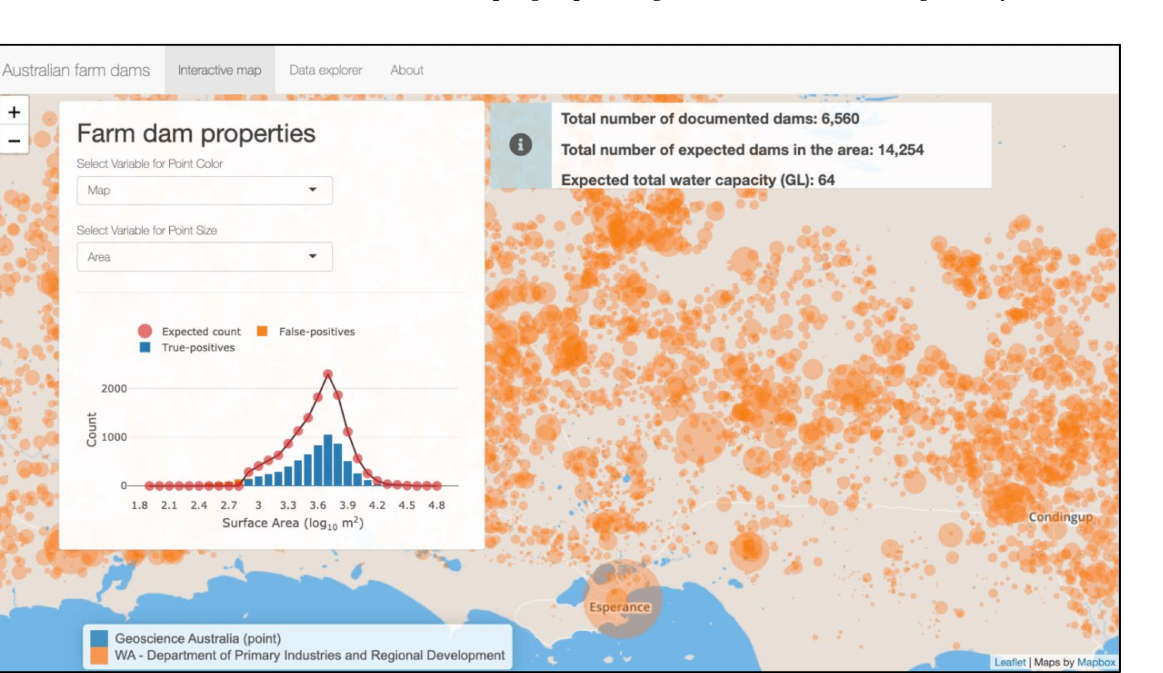
Supplementary Materials: The following items are available online at https://www.mdpi.com/20 CNN. Figure S2: The surface area of unreported dams used to estimate their median water capacity. Figure S3: Examples of undocumented farm dams that were identified with our deep learning CNN. Figure S4: Step-by-step graphical diagram for the methods to calculate the absolute and